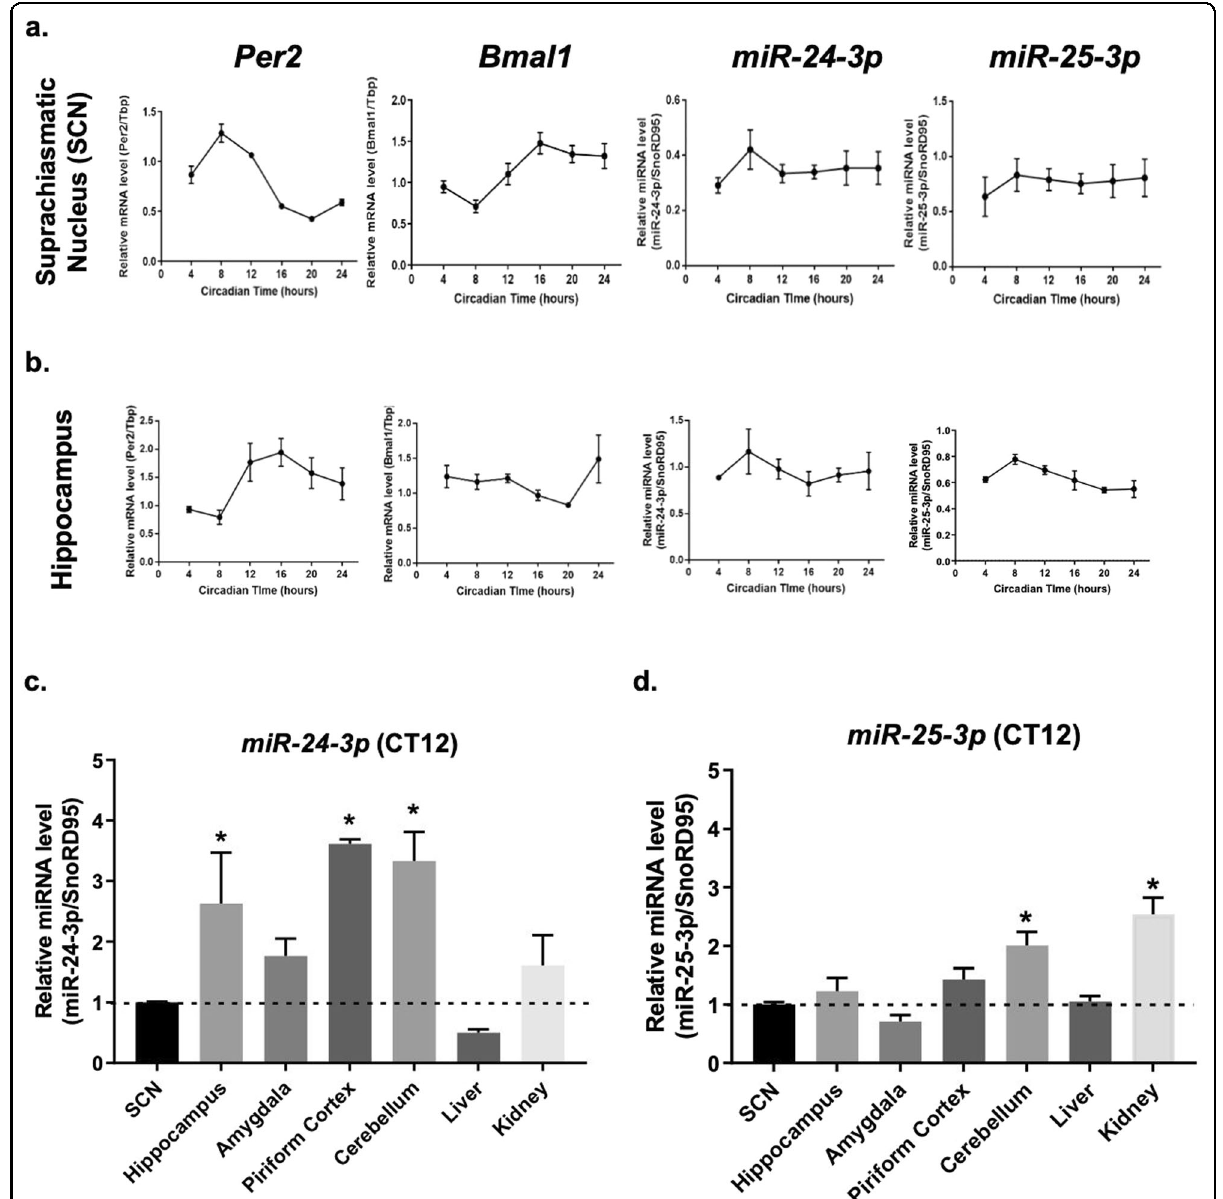
Fig. 6 Expression levels of miR-24-3p and miR-25-3p vary in brain regions and peripheral organs. WT mice housed under constant dark conditions for seven days were sacri fi ced at CT04, 08, 12, 16, 20, and 24 h for measurements of the indicated brain and peripheral tissues. Expression pro fi les of the circadian clock genes ( Per2 and Bmal1 mRNAs), miR-24-3p, and miR-25-3p in the a SCN and b hippocampal brain tissues were obtained by real-time qPCR with the relative quanti fi cation method. Expression levels of c miR-24-3p and d miR-25-3p in various brain and peripheral tissues were examined. CT12 tissue samples were used and normalized to the SCN miR-24-3p or miR-25-3p level. Data for the Per2 and Bmal1 mRNAs were normalized by the TATA-box binding protein ( Tbp ) housekeeping gene, while the miR-24-3p and miR-25-3p data were normalized by small nucleolar RNA, C/D Box 95 ( SnoRD95 ). Error bars represent the means ± SE of A.U. for each time point measured in three independent measurements. Signi fi cance was assessed by one-way ANOVA, * p < 0.05 compared to the control